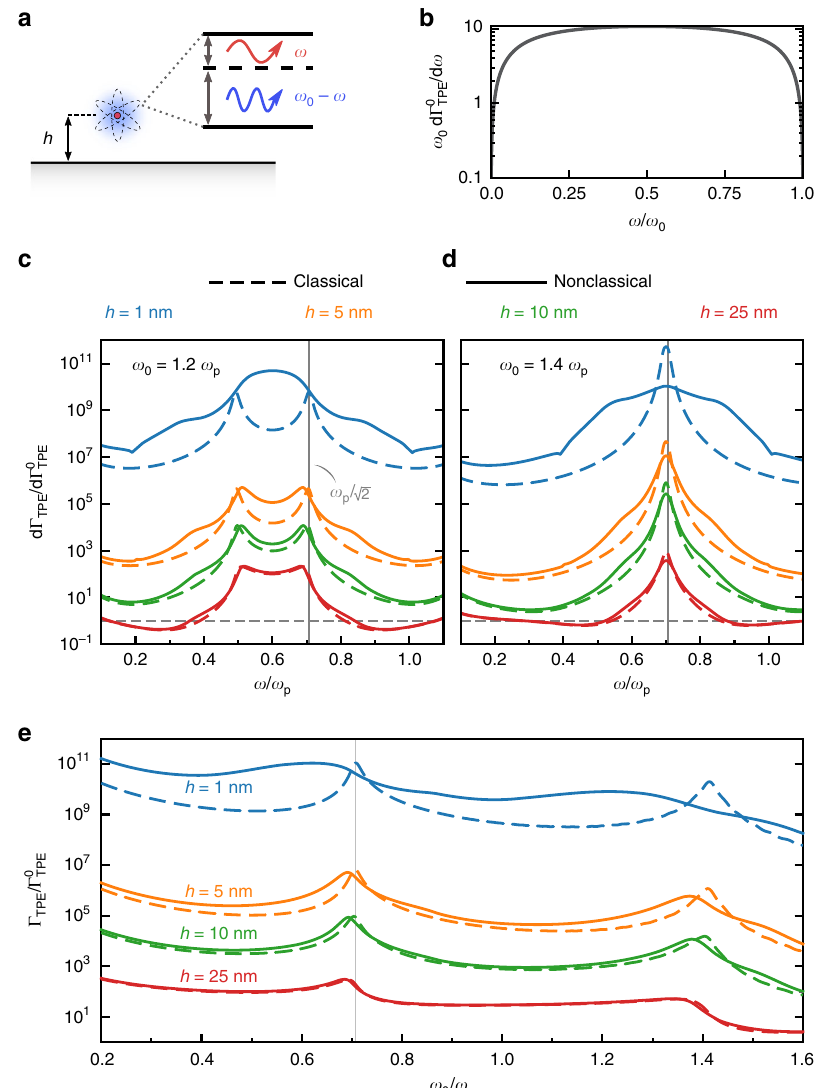
Fig. 6 Nonclassical corrections to two-photon emission enhancement. a Two-photon emission (s ! s transition) of a hydrogenic atom above a planar air – metal interface. b Differential decay rate in free-space for the 2s ! 1s two-photon transition in hydrogen. c , d Enhancement of the differential decay rate d Γ TPE = d ω , Eq. (10), as a function of frequency for different emitter – interface separations at a transition frequency of ω 0 ¼ 1 : 2 ω p (1 : 4 ω p ). e Enhancement of the integrated two-photon decay rate Γ TPE , as a function of transition frequency and emitter – surface Figure 6c – d contrast the classical and nonclassical predictions of the differential two-photon emission enhancement near a metal surface for different values of the (hydrogen-like emitter ’ s) transition frequency, its separation from the surface, and emission frequency. For separations ≳ 10 nm nonclassical effects modify the physics quantitatively, but not qualitatively. Devia- tions from classicality substantially increase at the separation of 5 nm, with clear hallmarks of nonclassical broadening in particular. At a 1 nm separation, the classical and nonclassical predictions ¼ 1 : 2 ω differ qualitatively: at the transition frequency ω 0 p (Fig. 6c) the peak-structure and position is mostly dissimilar (as ¼ peak is similarly displaced from the classical prediction); at ω 0 (Fig. 6d), the classical and nonclassical peak positions still 1 : 4 ω p coincide but the nonclassical spectrum is far broader.